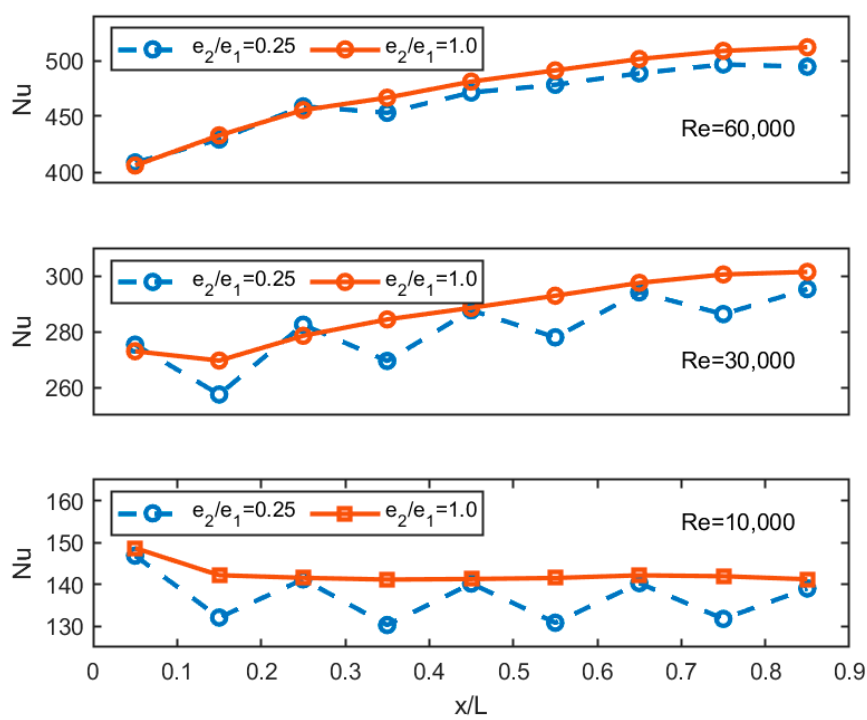
Figure 8. Average Nusselt number between the ribs along the test section at e 2 /e 1 values of 0.25 and 1.0, Re values of 10,000, 30,000, and 60,000, and a Pr number of 7.0.